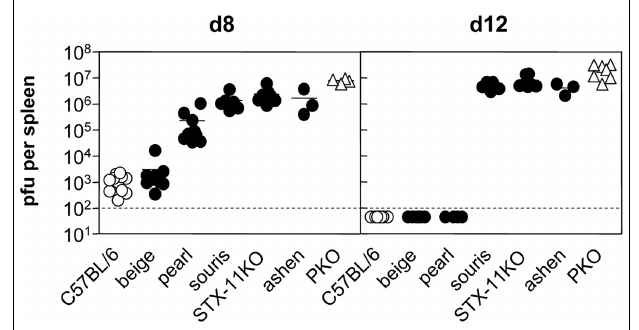
FIGURE 2 |Virus control following LCMV infection differs between various HLH-prone mouse models . Mice were infected with 200pfu LCMV i.v. On day 8 and day 12 after LCMV infection, viral titers in spleen of beige , pearl , souris , STX-11KO , and ashen mice (filled circle) in comparison to wild-type (open circle) and PKO (open triangle) mice were determined.